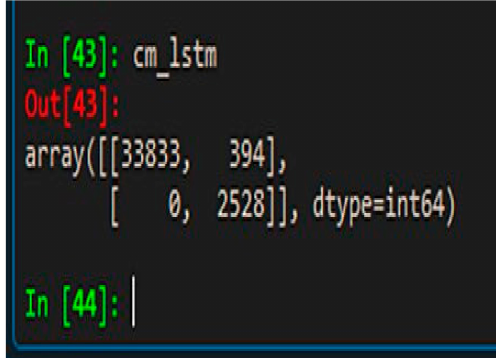
Figure 9. Confusion matrix.